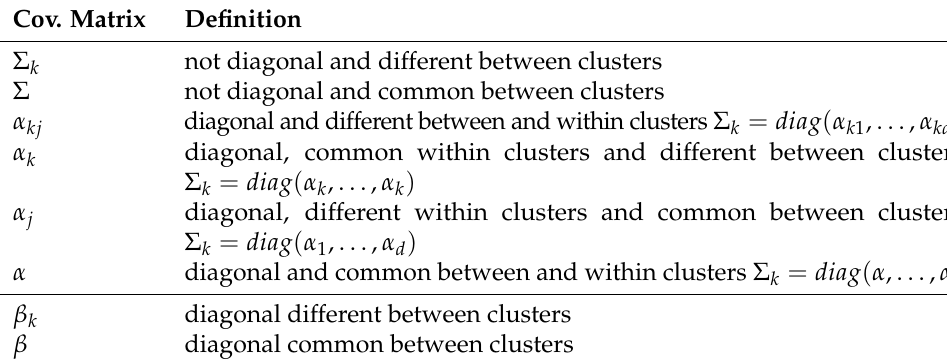
Table A1. Detailed description of the formalization of model-based